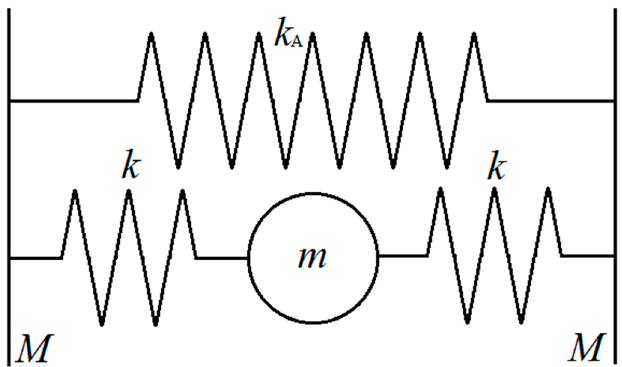
Figure 5. The “base ‐ spring ‐ mass” simplified model of vibration modes. Figure 5. The “base-spring-mass” simplified model of vibration